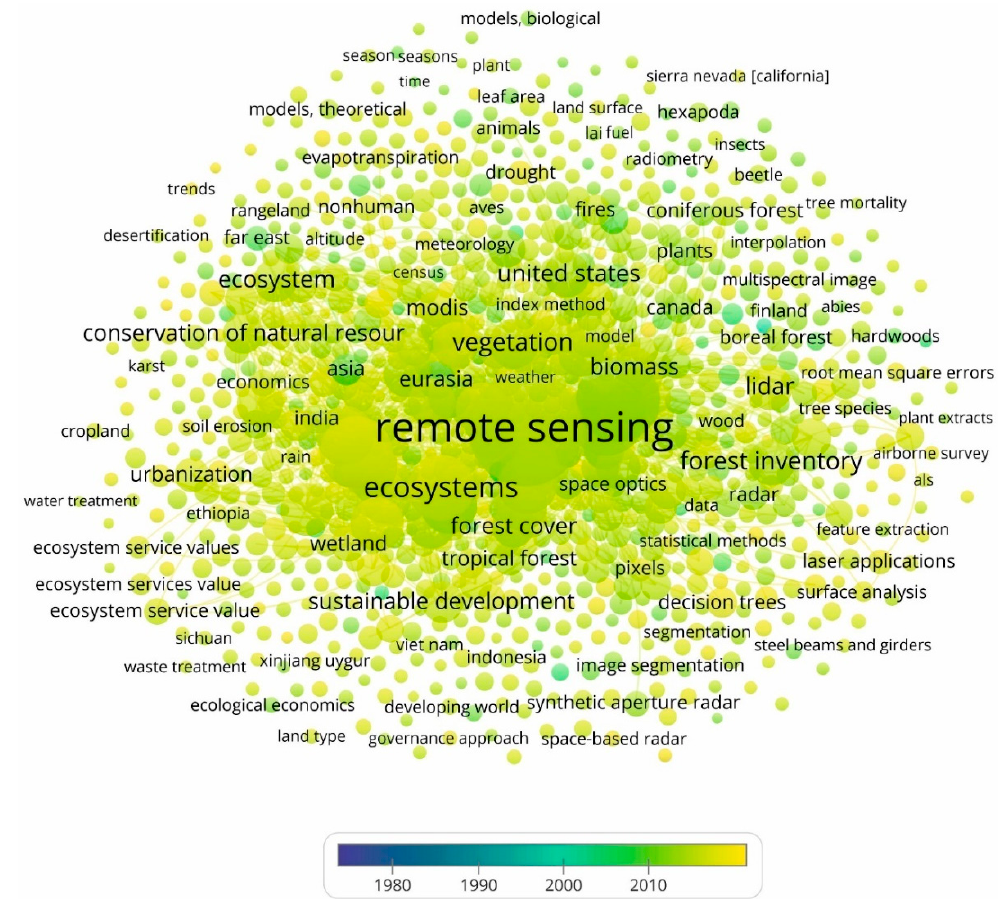
Figure 8. Evolution of keywords network based on co-occurrence method (1976–2019).